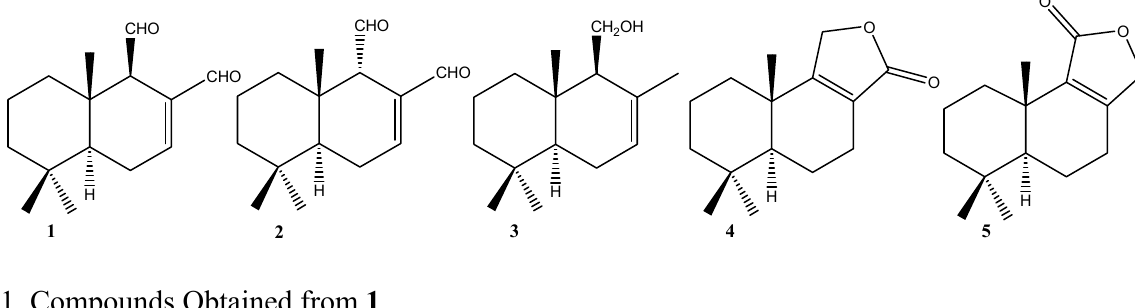
Figure 1. Structure of natural drimanes from bark of the D. winteri